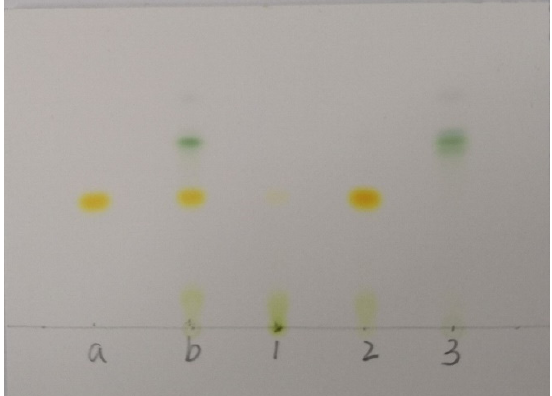
Figure 3. TLC analysis of samples taken throughout the fractions obtained during the ODS chromatographic purification with three-step gradient (70%, 90%, and 100% in ethanol:water, v / v ). Sample a, FX standard; Sample b, the crude S. horneri extract; Sample 1, the fraction eluted by ethanol:water (7:3, v / v ); Sample 2, the fraction eluted by ethanol:water (9:1, v / v ); Sample 3, the fraction eluted by absolute ethanol.